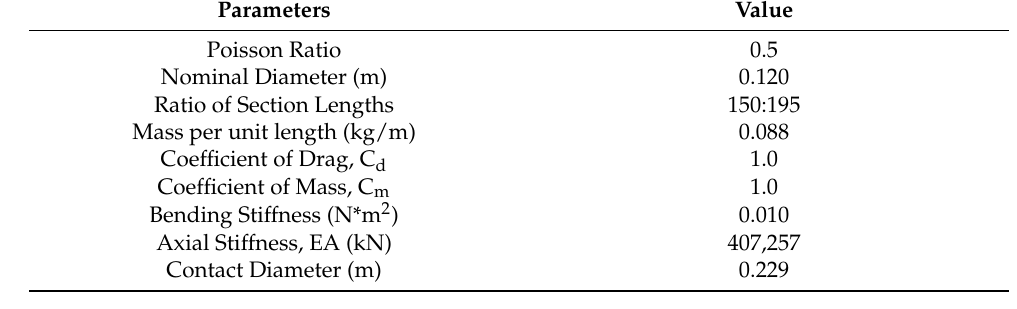
Table 3. Mooring Lines Parameters.